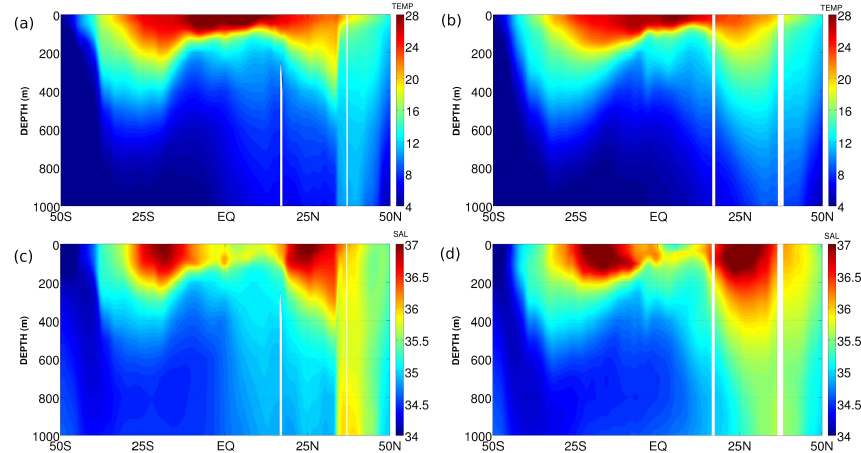
Figure 1. Mean temperature ( ◦ C) and salinity (psu) in the upper 1000m along 25 ◦ W for (a) averaged simulated temperature from January 1997 to December 2008, (b) climatological temperature from WOA13, (c) averaged simulated salinity from January 1997 to December 2008, and (d) climatological salinity from